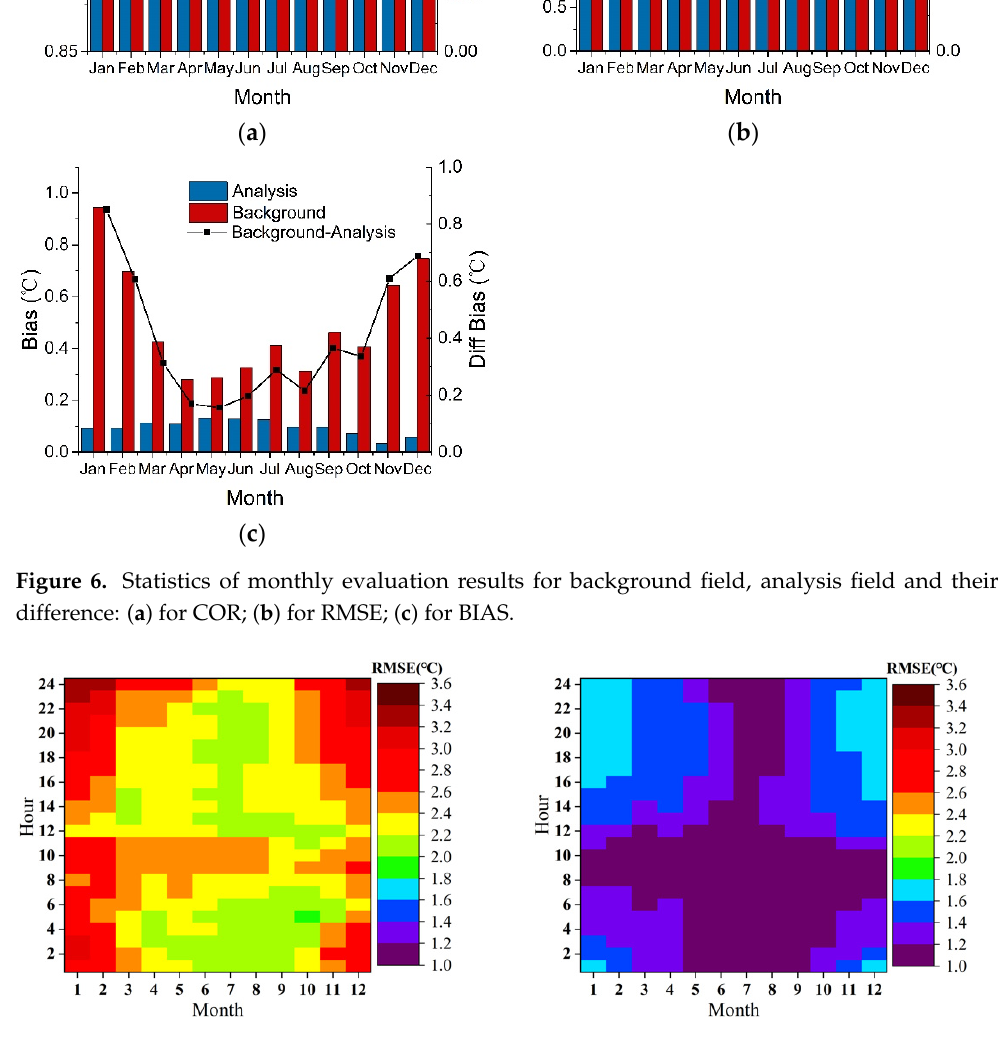
Figure 6. Statistics of monthly evaluation results for background field , analysis field and their dif- ference: ( a ) for COR; ( b ) for RMSE; ( c ) for BIAS.